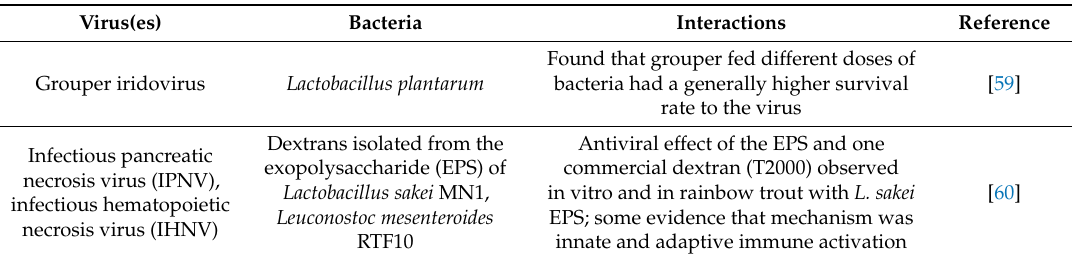
Table 3. Eukaryotic virus–bacteria interactions in food